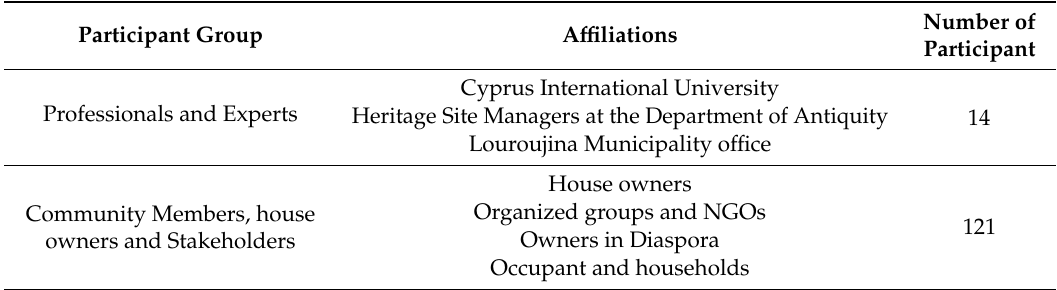
Table 5. The characteristics of the participants used for the questionnaire